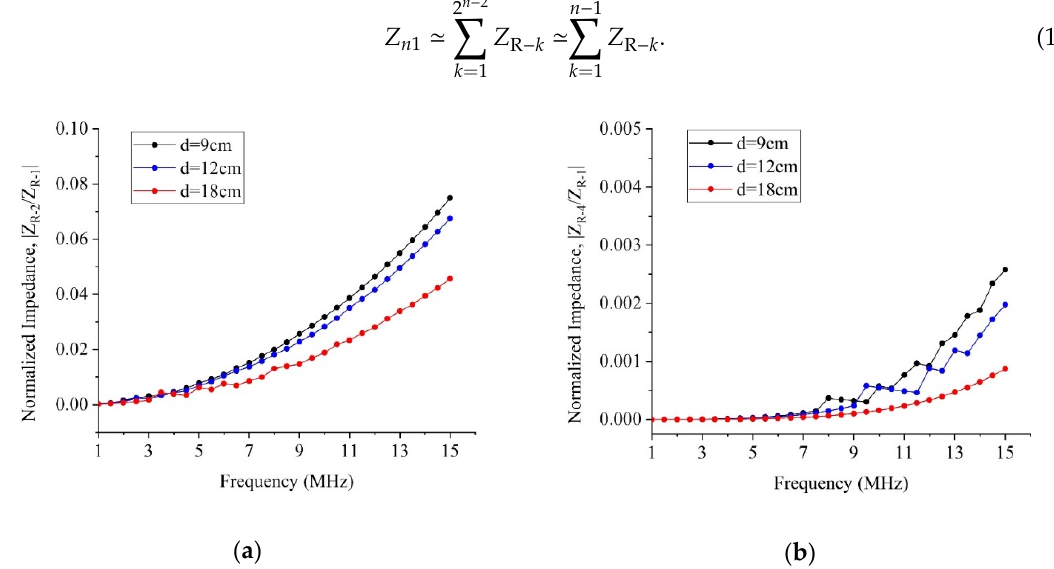
Figure11. Normalizedtransferimpedanceinthearrayoffourcoils: ( a )One-hop; and( b )two-hoproutes. Figure 11. Normalized transfer impedance in the array of four coils: ( a ) One-hop; and ( b ) two-hop routes.